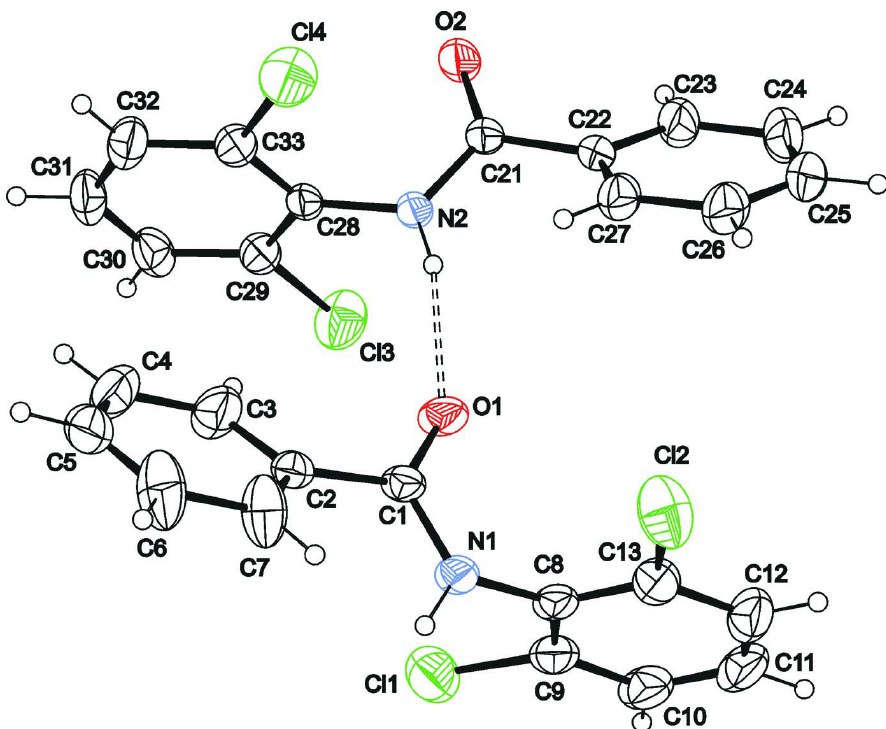
Figure 1 Molecular structure of the title compound showing the atom labelling scheme. Numbers of the C atoms in the second molecule are increased by 20. Displacement ellipsoids are drawn at the 30% probability level. The hydrogen bond N2— H2N···O1 is shown as a dashed